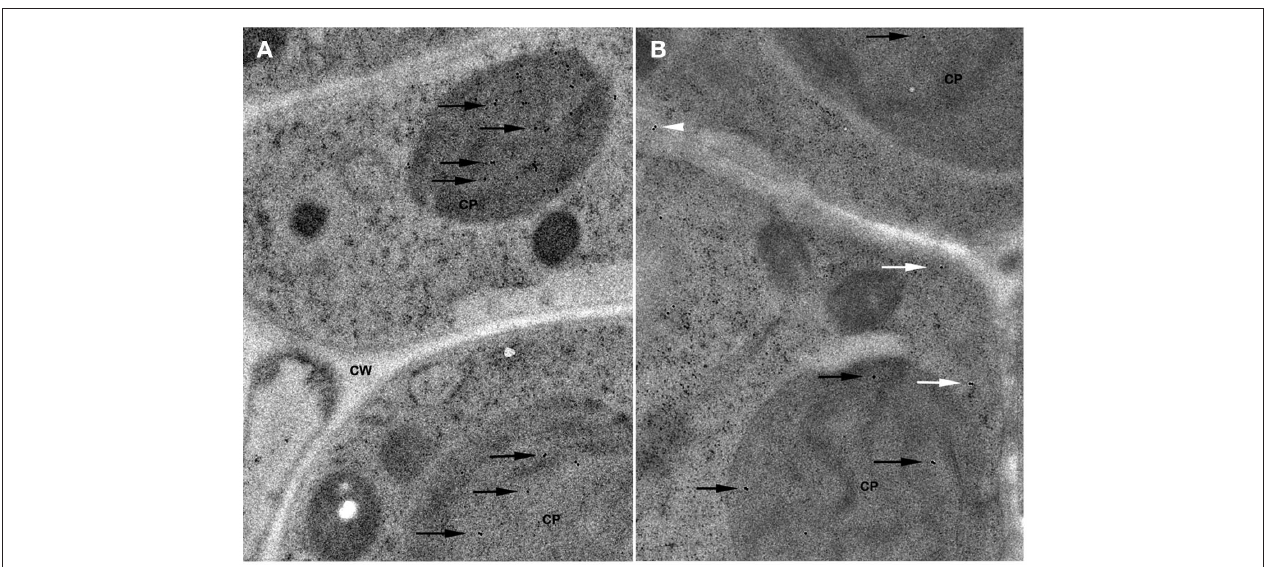
Figure 2 | Localization of glutathione biosynthesis enzymes in Arabidopsis leaf cells. (A) Localization of GCL. Immunocytochemical labeling with α -GCL and gold-labeled secondary antibody is shown. Labeled GCL within the chloroplast (CP) is indicated by black arrows. Cell wall (CW) is also